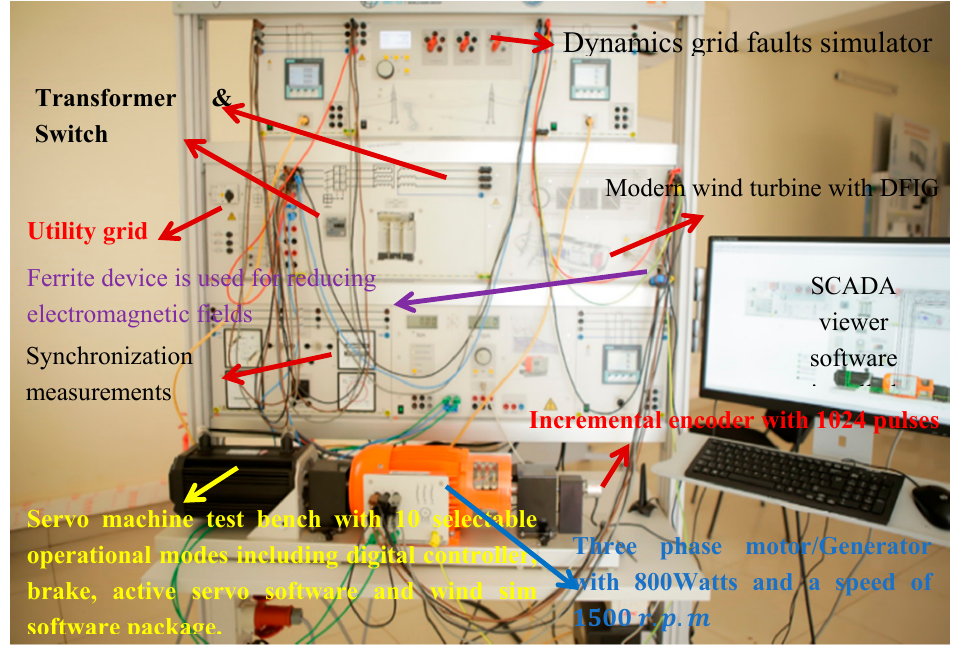
Figure 12 .Detailed experimental set up. Figure 12. Detailed experimental set